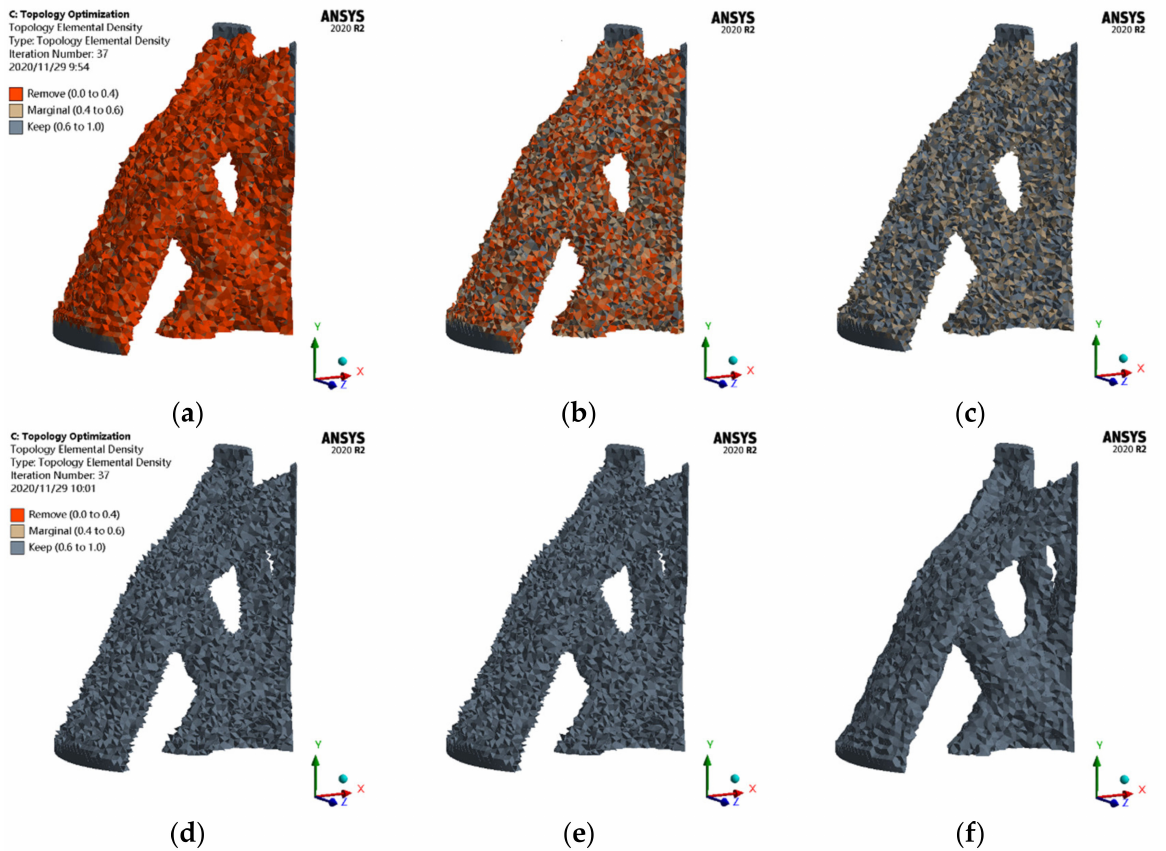
Figure 6. Isosurface map of ANSYS: ( a ) ρ ≥ 0.1; ( b ) ρ ≥ 0.3; ( c ) ρ ≥ 0.5; ( d ) ρ ≥ 0.7; ( e ) ρ ≥ 0.9; ( f ) ρ =